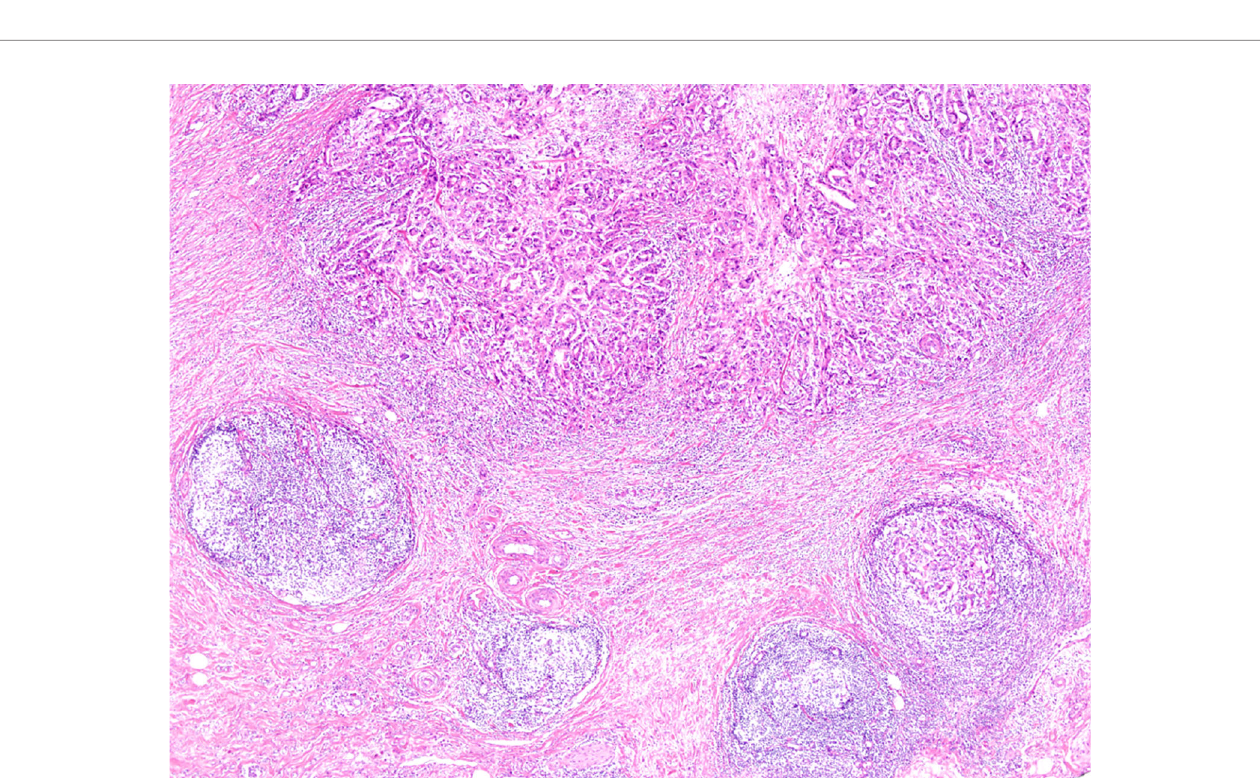
FIGURE 5 | Representative image of Crohn-like lymphoid reaction observed at an advanced tumor edge (magni fi cation,